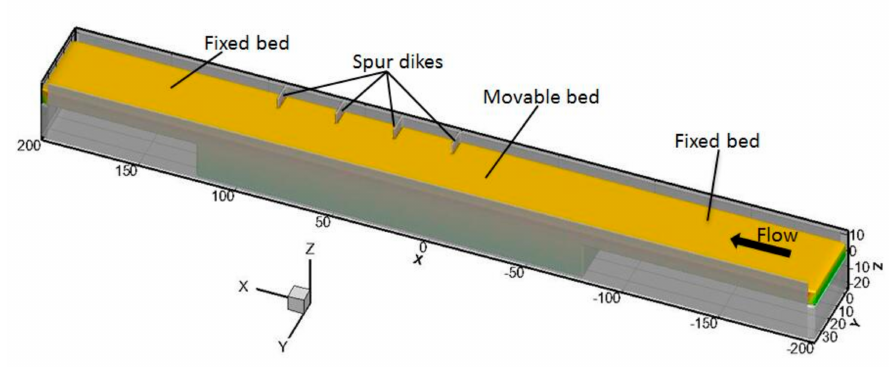
Figure 3. Computational domain (units: